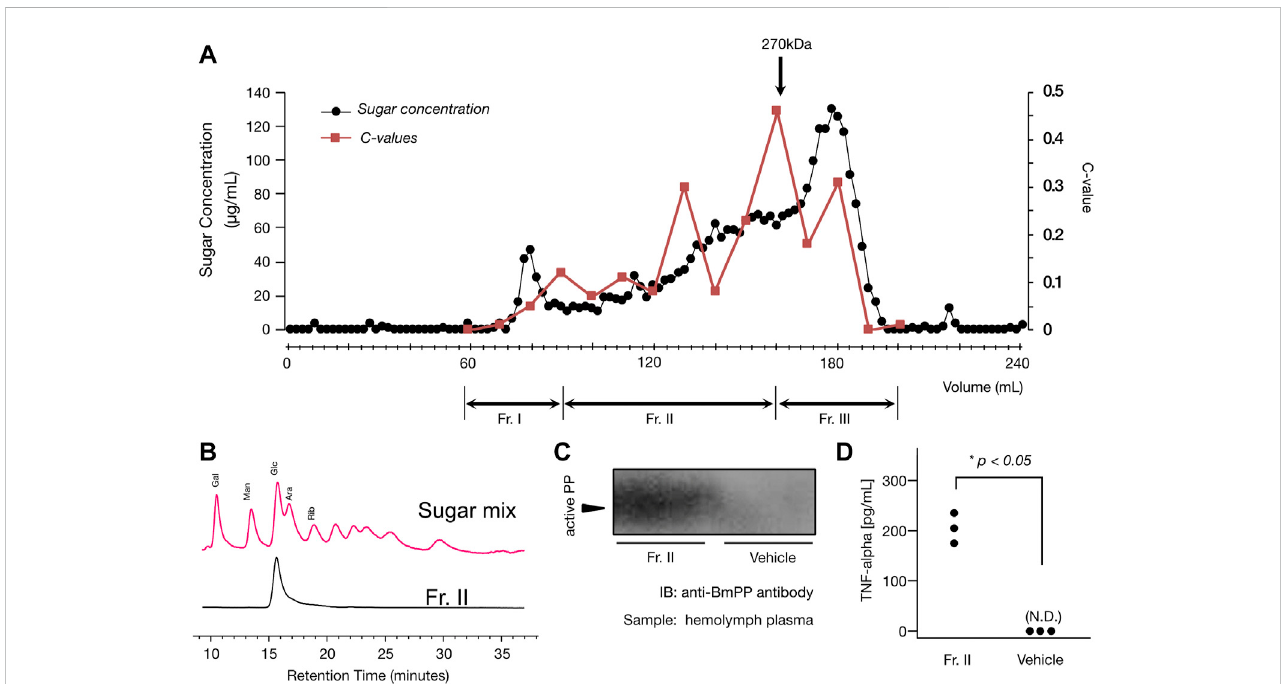
FIGURE 2 (A) Elutionpro fi leofSephacrylS-1000 gel fi ltrationcolumnchromatography.Theelutionpro fi leofthegel fi ltrationcolumnchromatographyisshownin the fi gure.The x -axisrepresentselutionvolume(mL),andthe y -axesrepresentsugarconcentration(µg/mL)ofeachfraction(theleftaxis)andthecontraction value (the rightaxis). Method details for thechromatography, sugar quanti fi cation, and contraction valueestimationare described inthemethodsection.The black circles represent the sugar concentrations, and the red squares represent the contraction values. As shown in the chart, we pooled fractions into threefractions:Fr.I,II,and III.Inthisstudy,Fr.II wasused forfurtheranalysis.Pleasealso seeTable 2forthepuri fi cationtable. (B) Sugarcomponentanalysis of the puri fi ed immunostimulatory neutral polysaccharide (Fr. II). Shown in the fi gure is the HPLC chart of sugar component analysis. The x -axis represents retentiontime(minutes).TheredchartrepresentstheHPLCpatternfromABEE-labelledsugar(monosaccharide)mixture.Eachpeakisannotatedasdescribed inthemethodsection.TheblackchartrepresentstheHPLCpatternfromABEE-labelledhydrolyzedsample(Fr.II).Asshowninthe fi gure,Fr.IIshowedasignal from ABEE-labelledglucose, and othermonosaccharides wereunder thedetection limit. See the method section for technical details for this experiment. (C) Activation of Paralytic Peptide (BmPP) in the response to broccoli-derived neutral polysaccharide (Fr. II). Silkworm hemolymph samples were run on an SDS- polyacrylamidegeland theactive BmPP wasdetectedbyimmunoblot analysis usinganti-PPantibody.Hemolymphsampleswerecollected 3 min aftereither